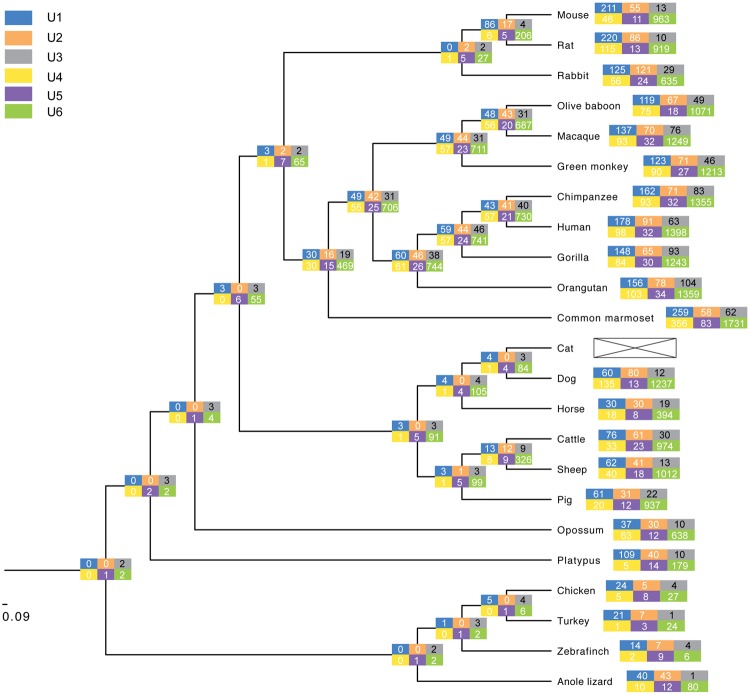
Estimating evolutionary conservation of individual ncRNAs using whole-genome alignments. Conservation of individual U1–U6 loci was reconstructed using a whole-genome alignment of 23 amniote genomes (EnsEMBL release 83). The RNA gene build for cat was absent from several releases in EnsEMBL, including the one used for this study, and is therefore not included in our reconstruction. Deep conservation to the amniote ancestor was tractable only for at most 1–2 copies per family, compatible with the notion of a recent expansion in the mammalian lineage and lack of long-term conservation of the resulting retrogene copies. Lack of deep conservation for some loci/families may be attributable to challenges in aligning a large number of genomes over comparably large evolutionary time scales.